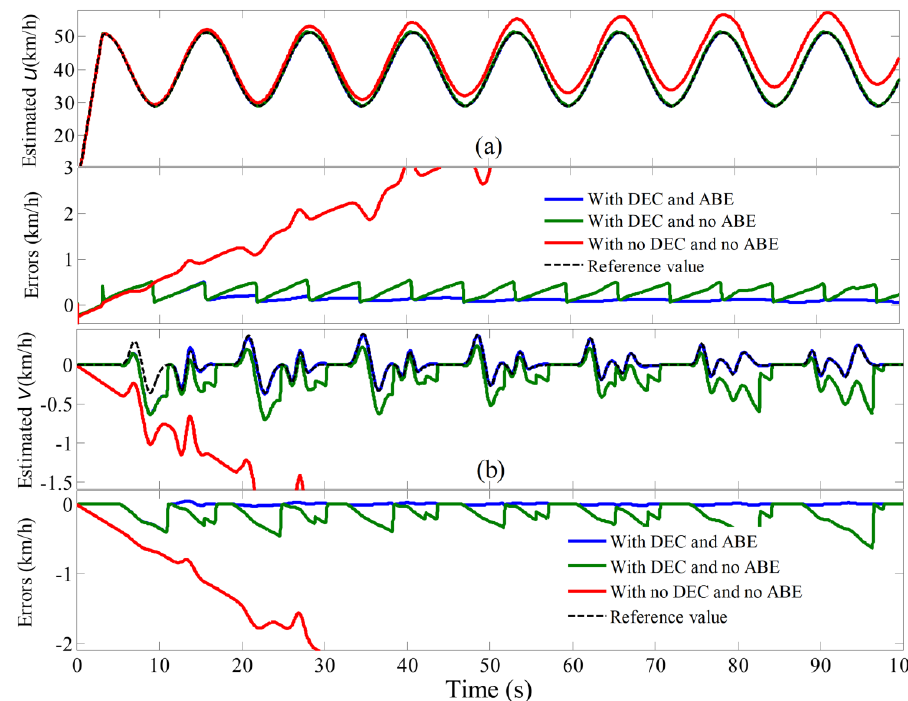
Figure 10. The estimated velocities during the consecutive DLC test: ( a ) longitudinal velocity; ( b ) lateral velocity.